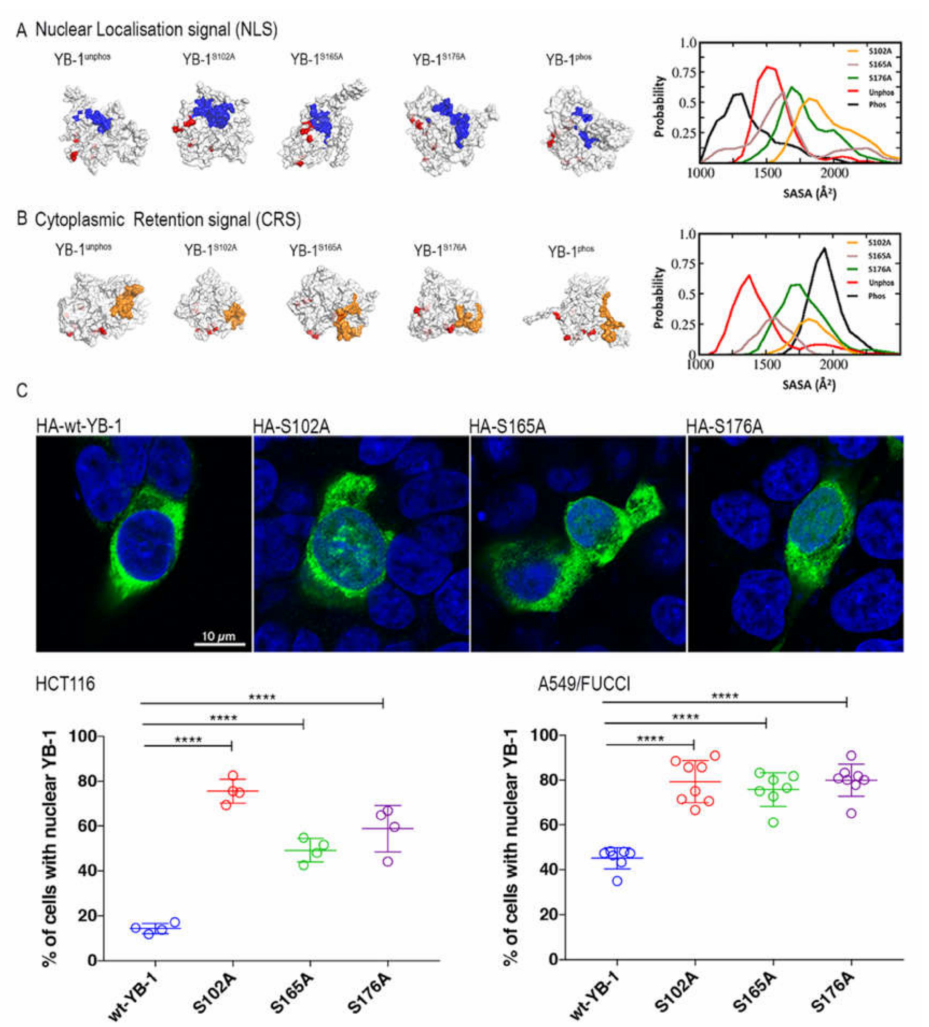
Figure 5. Phosphorylation of serine residues a ff ects both NLS and CRS accessibility. ( A ) the solvent accessible surface area (SASA; blue) of the nuclear localisation signal (NLS; residues 183–205) in (from left to right) YB-1 unphos , where the serine residues are not phosphorylated; YB-1 with serine 102 mutated to an alanine (YB-1 S102A ); YB-1 S165A ; YB-1 S176A . A model of the NLS SASA when all serine residues are phosphorylated (YB-1 phos ) is shown on the right. The graph on the far right shows the SASA range for each of the models generated with NACCESS. ( B ) the solvent accessible surface area (SASA; orange) of the cytoplasmic retention signal (CRS; residues 247–267) in (from left to right) YB-1 unphos , where the serine residues are not phosphorylated; YB-1 with serine 102 mutated to an alanine (YB-1 S102A ); YB-1 S165A ; YB-1 S176A . A model of the CRS SASA when all serine residues are phosphorylated (YB-1 phos ) is shown on the right. The graph on the far right shows the SASA range for each of the models generated with NACCESS. C, shows (from left to right) confocal images of HCT116 cells with HA-tagged wild type (wt)YB-1 (green); HA-tagged YB-1 S102A ; YB-1 S165A and YB-1 S176A . Cell nuclei are stained with Hoechst (blue). The graphs on the right-hand side show the quantification of the percentage of cells with nuclear YB-1 in both HCT119 and A549_FUCCI cells. Each circle represents one experiment where at least 100 cells were analysed. The increase in the percentage of cells with nuclear YB-1 between those transfected with wtYB-1 or with a plasmid containing serine to alanine mutations, in both cell lines is highly significant ( p <